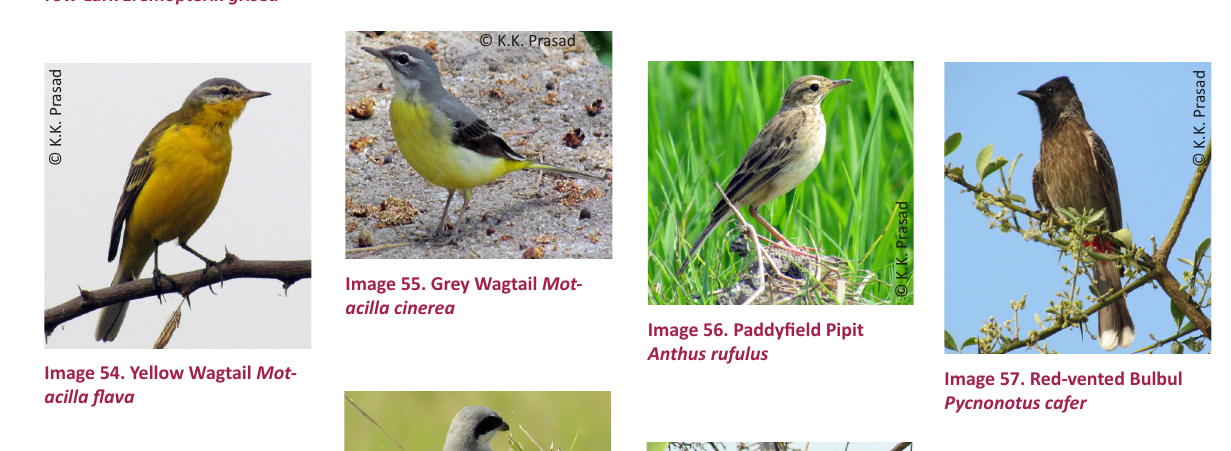
Image 54. Yellow Wagtail Mot- acilla flava